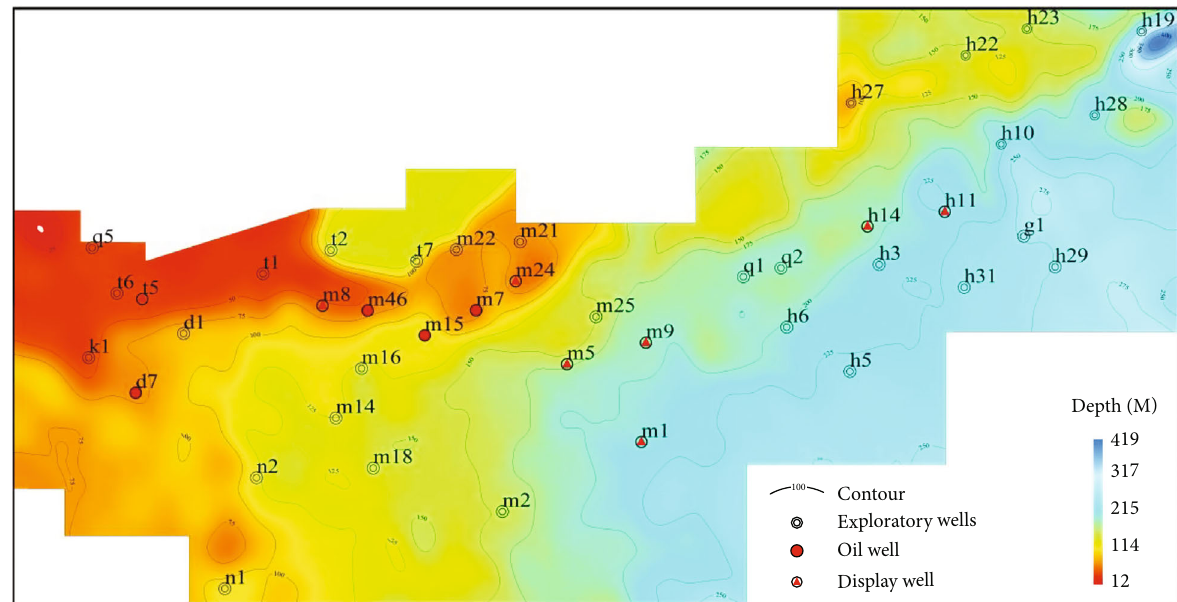
Figure 13: Paleogeomorphology before deposition of the Cretaceous in the western Tabei area.